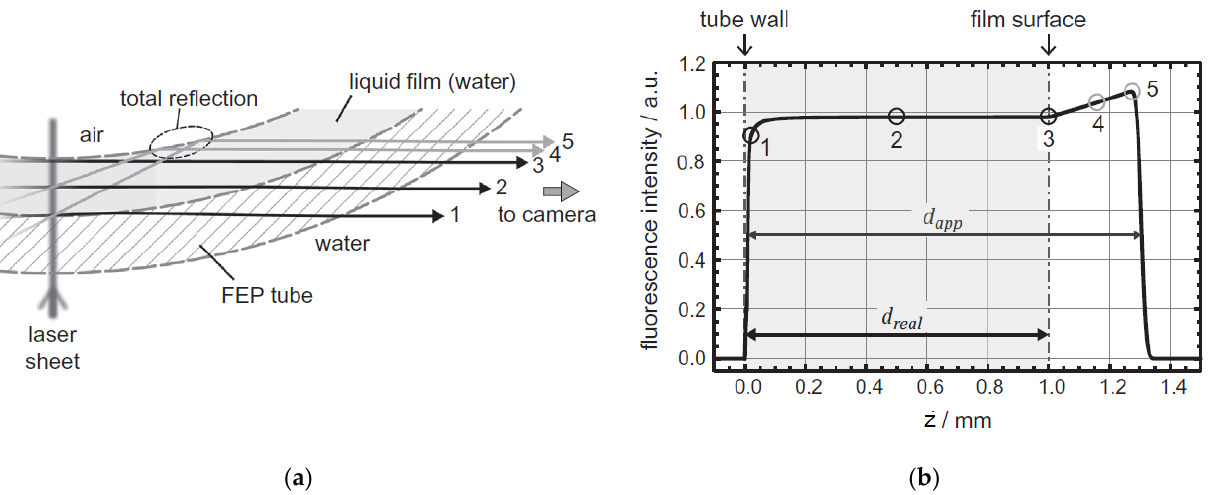
Figure 3. The distortion of PLIF measurements in a pipe due to mirror effect ( 𝜃 = 90°): ( a ) Rays leading from the glowing section of liquid film to the camera. Rays (1–3) go to camera directly, whilst rays (4–5) go to camera after total reflection at the interface [99]; ( b ) The modeled distribution of registered fluorescence intensity created by rays from 1 to 3 (true film image) and rays from 3 to 5 (false film image) [99].